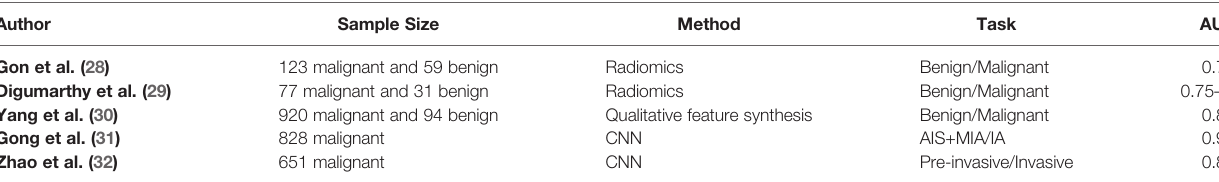
TABLE 5 | Other studies for the classi fi cation of pulmonary